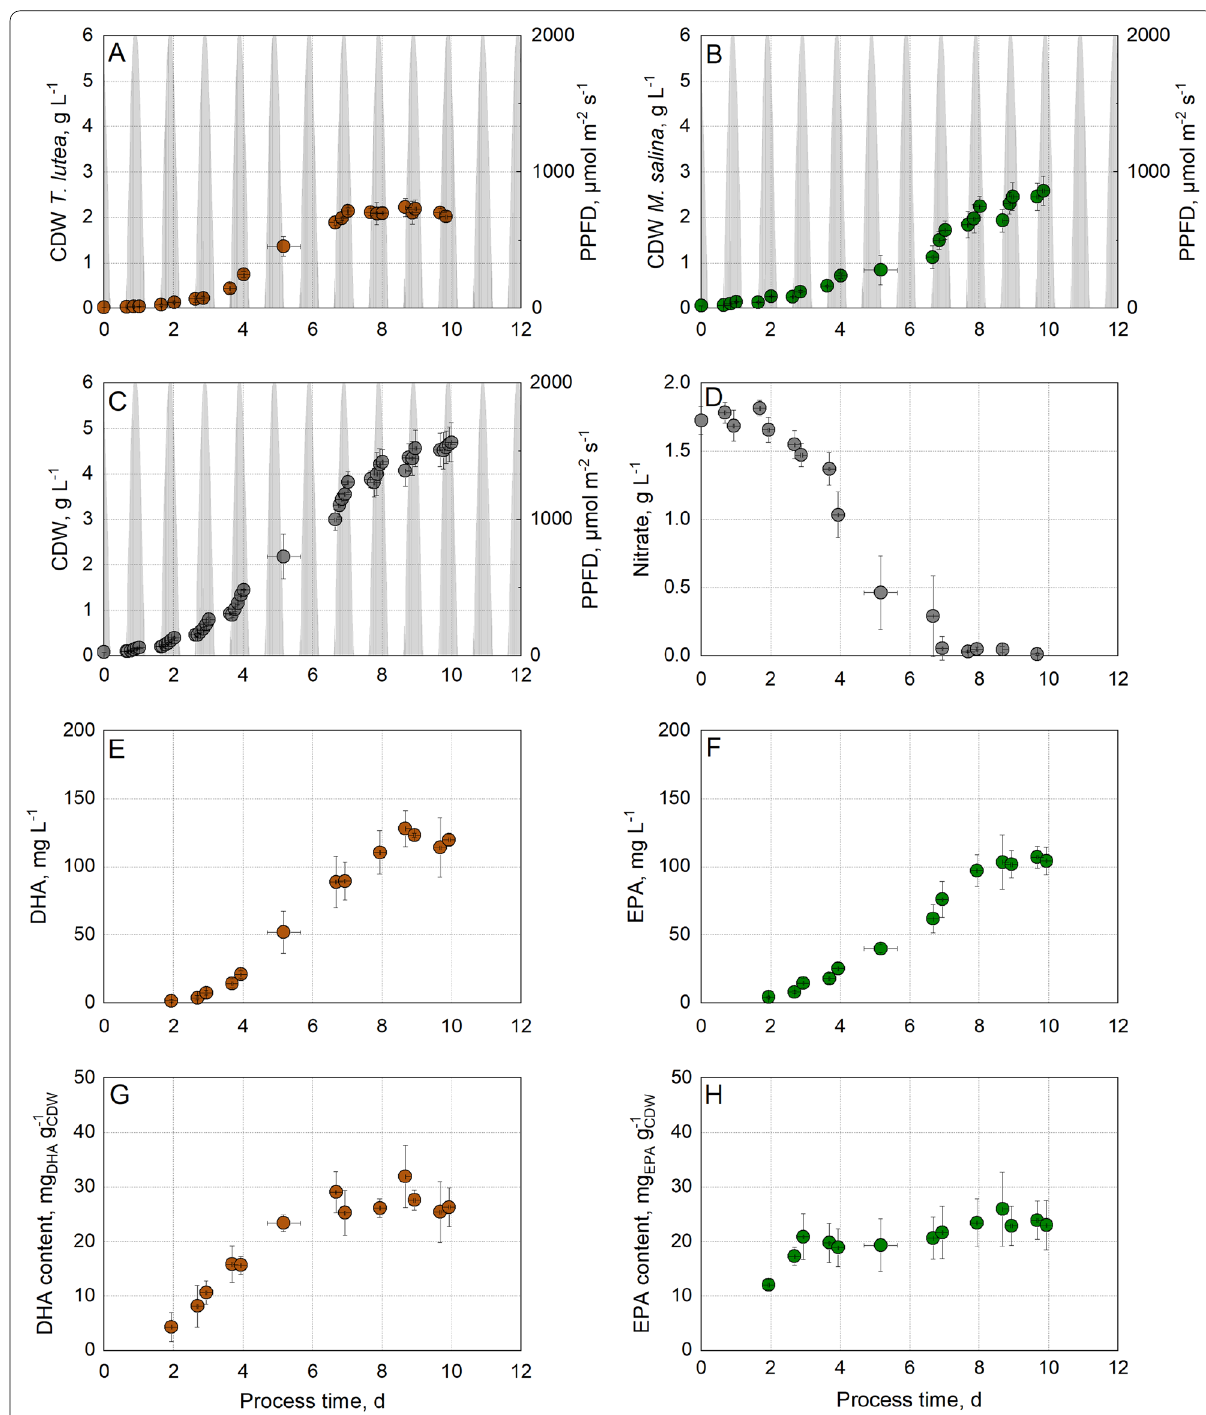
Fig. 5 Phototrophic batch process with T. lutea (red circle) and M. salina (green circle) in co‑culture with an inoculation ratio of 1:3 in flat‑plate gas‑lift photobioreactors under simulated climate conditions. A cell dry weight concentration of T. lutea , B cell dry weight concentration of M. salina , C total cell dry weight concentration, D nitrate concentration, E DHA concentration, F EPA concentration, G DHA content of total cell dry weight, H EPA content of total cell dry weight. The batch process was operated at a working volume of 1.8 L, pH 8.0 and an initial nitrate supply of 1.8 g L − 1 . Data are expressed as a mean SD ( n ± =